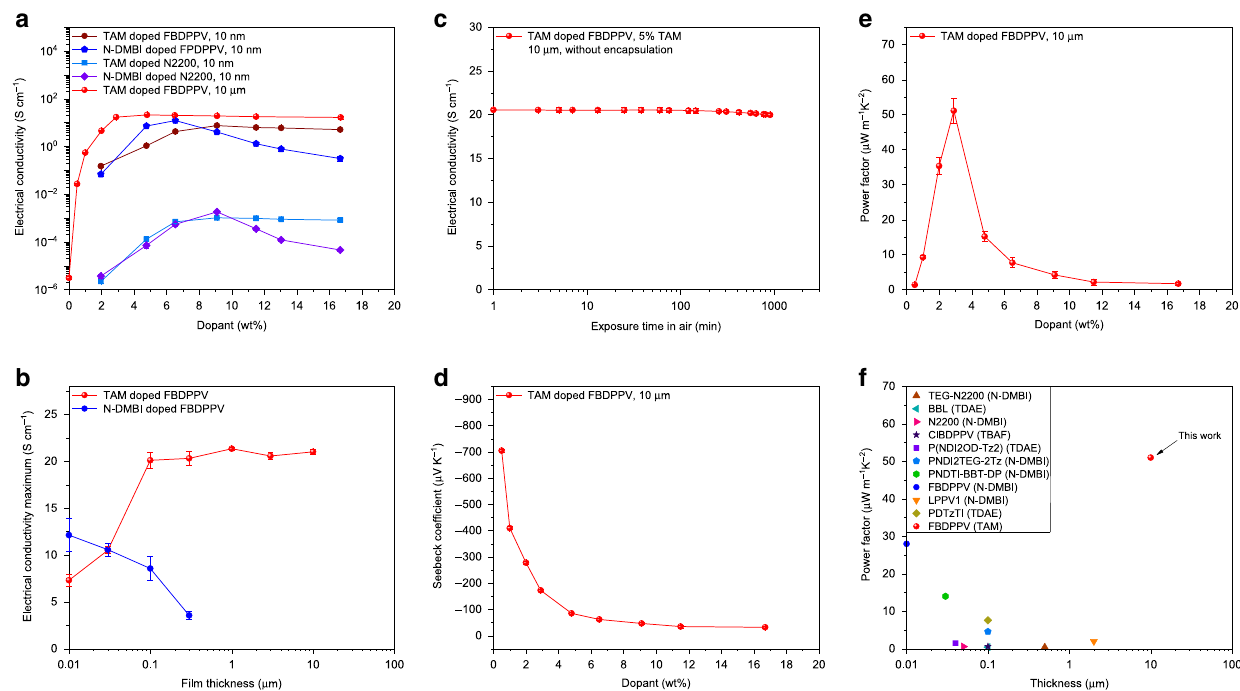
Fig. 4 Thermoelectric performance of TAM-doped organic semiconductors. a Dopant fraction-dependent electrical conductivity of TAM- and N-DMBI- doped polymers. b Thickness-dependent electrical conductivity maxima of TAM- and N-DMBI-doped FBDPPV. c Air stability of TAM-doped FBDPPV thick fi lms without encapsulation. d Seebeck coef fi cients of TAM-doped FBDPPV in thick fi lms. e Power factor of TAM-doped FBDPPV in thick fi lms. f Thermoelectric performance comparison of TAM-doped FBDPPV with literature results (refs. 11,24,26 – 30,53 – 58 ). Error bars indicate the SD of ten experimental replicates. TAM-doped polymers present ultra-high thermoelectric performance in high